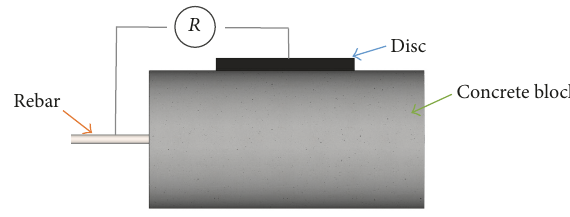
Figure 2: Setup of one electrode-disc: measurement of concrete resistivity (reproduced from